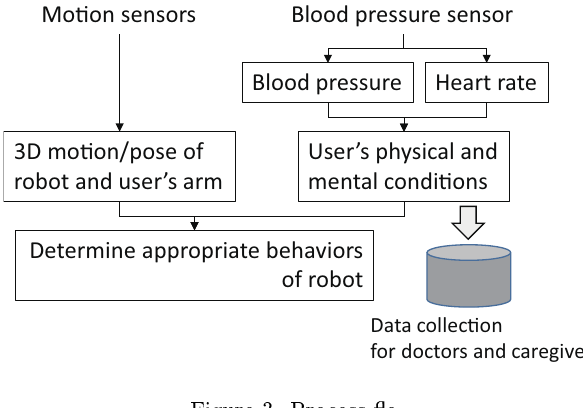
Figure 3: Process (cid:29)ow blood pressure